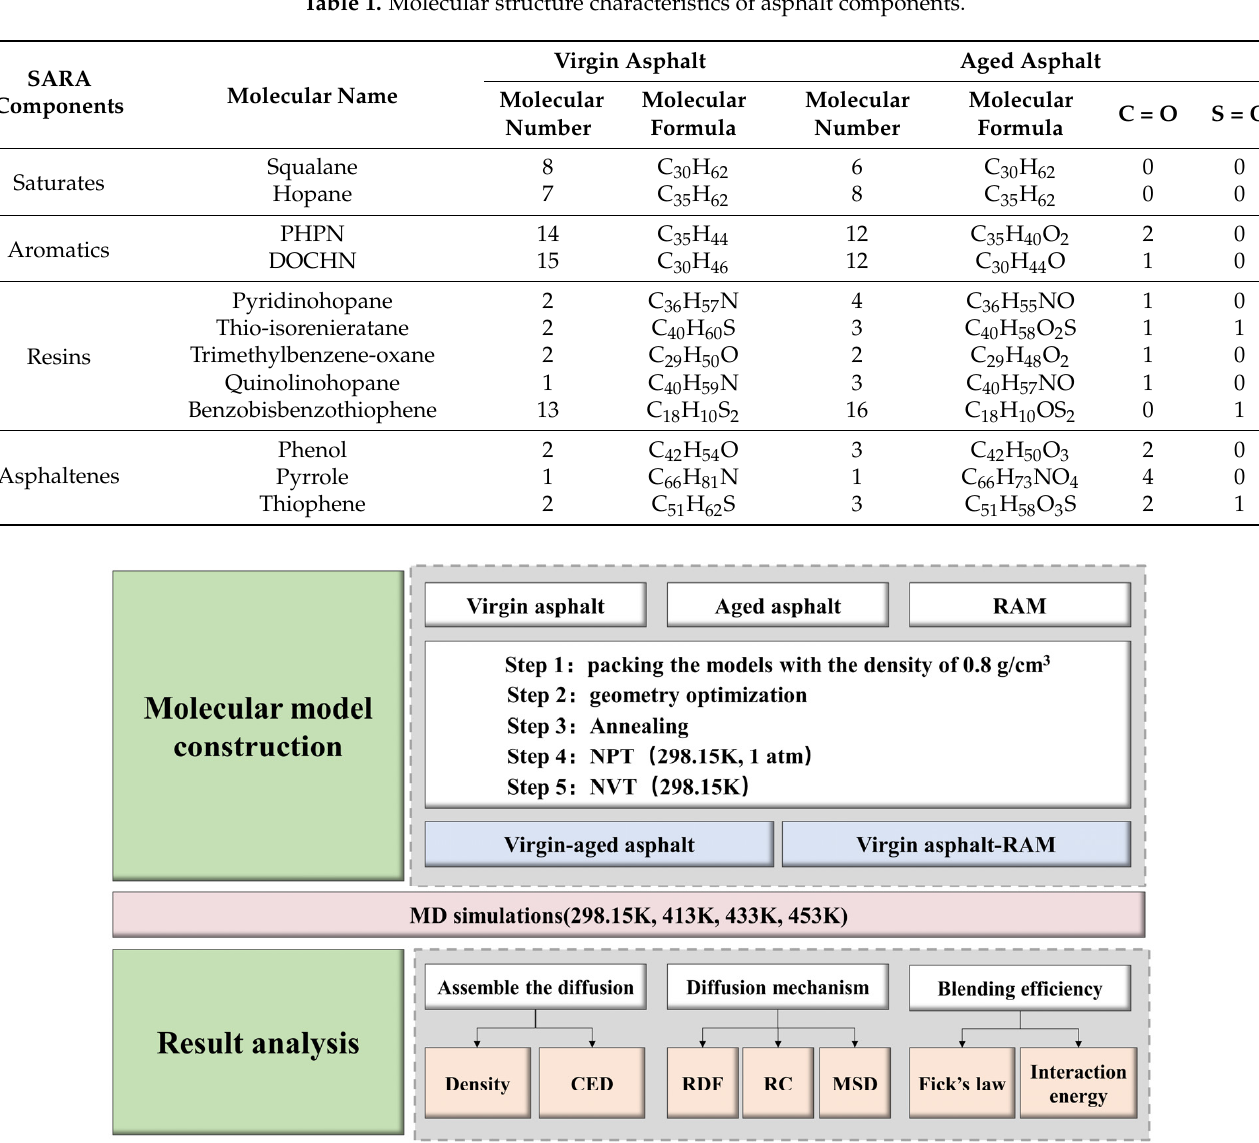
Table 1. Molecular structure characteristics of asphalt components.